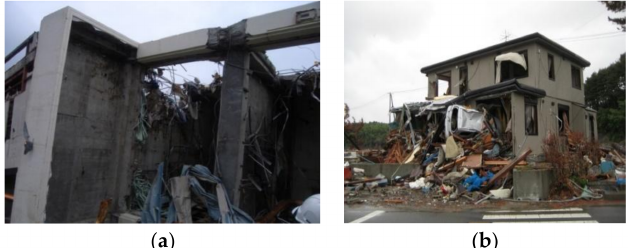
Figure 2. Evidence of debris effects on buildings, from the 2011 Japan Tsunami. ( a ) Likely large debris impact on the top floor of an overturned Reinforced Concrete-framed building; ( b ) Openings dammed by debris. (Photos: